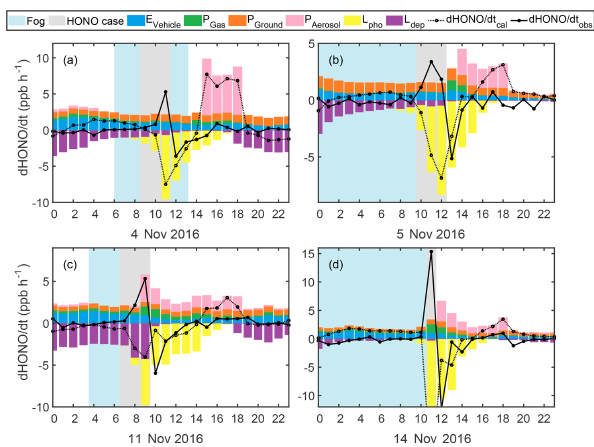
Figure 6. Estimated HONO emission from vehicles (blue), gas- phase production (green), production on ground (orange) and aerosol surface (pink), loss via photolysis (yellow) and dry deposi- tion (purple), as well as the calculated (dotted black) and observed (solid black) d [ HONO ] / d t on (a) 4, (b) 5, (c) 11 and (d) 14 Novem- ber